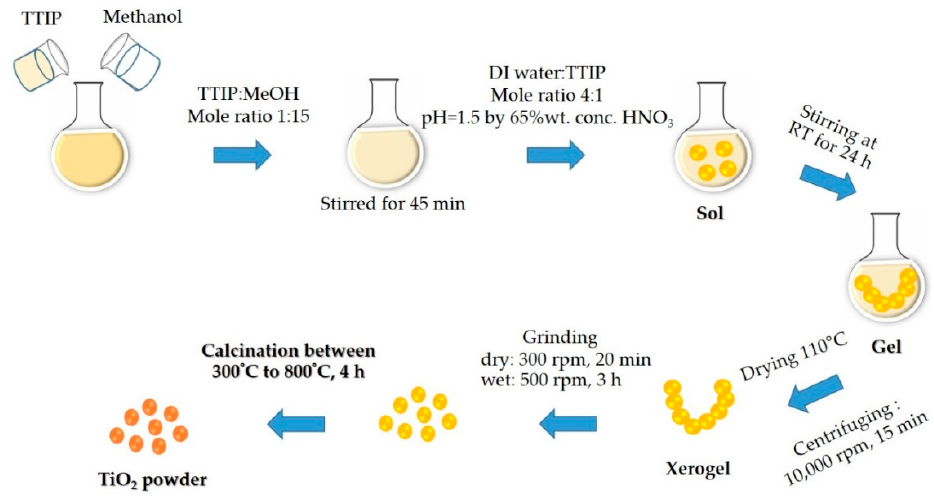
Figure 1. Synthesis of TiO 2 nanoparticles via wet ball milling sol-gel (WBMS) method .